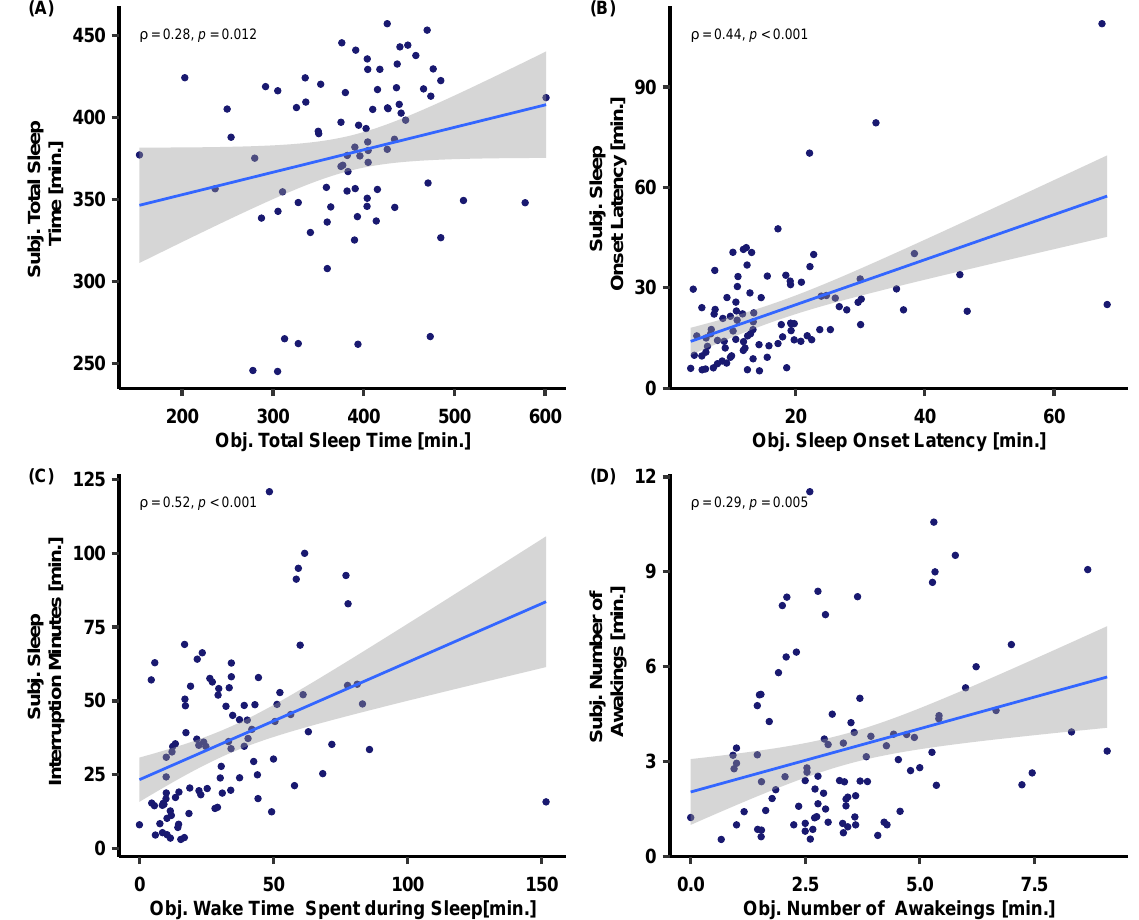
Figure 8. Spearman’s rank correlations ( ρ ) between subjective and objective ( A ) total sleep time, ( B ) sleep onset latency, ( C ) sleep interruption minutes, as well as ( D ) number of awakenings. Note that individual points correspond to weekly averaged sleep variables per